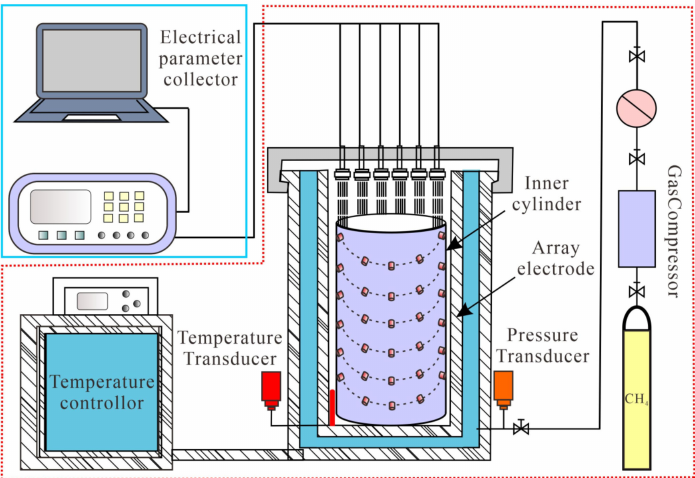
Figure 1. Electrical resistivity tomography device for gas hydrate.